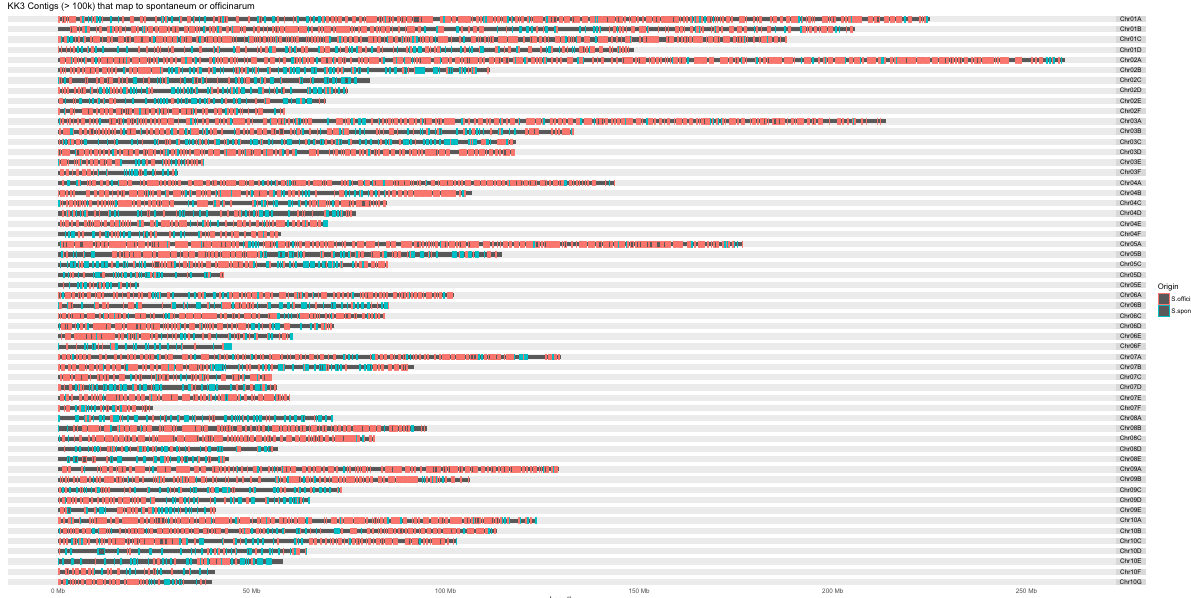
Figure 2. Chromosomes of KK3 showing length with similarity to each ancestral genome indicated by color. Each KK3 chromosome is represented by a horizontal bar with the length indicated on the x-axis. The ancestral origin of each contig larger than 100 kb, based on sequence alignment results, is indicated by colored rectangles on each chromosome. The size of colored rectangles is proportionate to the relative size of the contig, but not proportionate to the actual bp size. Pink represents contigs that had more sequence overlap with S. officinarum and teal represents S. spontaneum